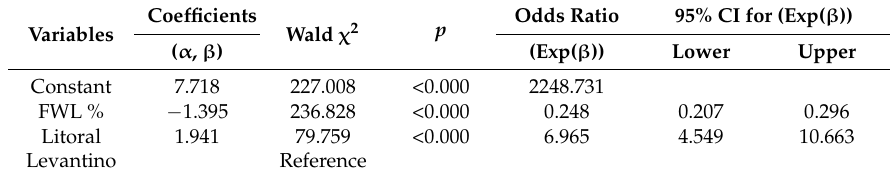
Table 7. Estimation of the multiple logistic regression parameters for cucumber cultivars (Levantino and Litoral) and FWL % during storage as factors influencing the probability of marketability.